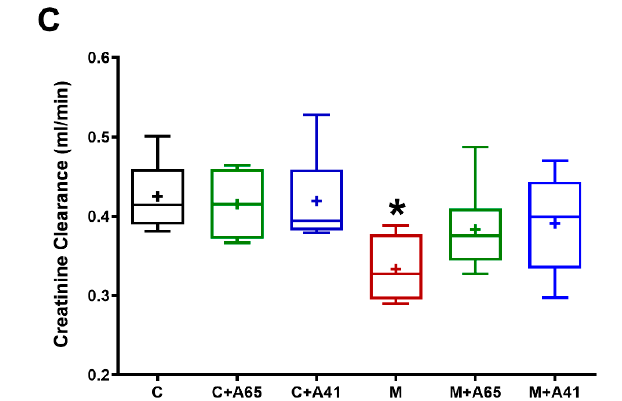
Figure 1. The CB1 receptor antagonists AM6545 and AM4113 improve renal functional parameters in high-fructose high-salt fed metabolic syndrome rats. ( A ) shows the albumin excretion rate (AER), ( B ) shows the proteinuria and ( C ) shows the creatinine clearance measured in control (C) and metabolic syndrome (M) rats as well as after 4 weeks of intraperitoneal injection of AM6545 in control (C + A65) and metabolic rats (M + A65) or AM4113 in control (C + A41) or metabolic rats (M + A41) at a dose of 10 mg/kg/day. Results are shown as box plots and the mean is shown as (+) ( n = 8). * p < 0.05 relative to the control group and # p < 0.05 relative to the metabolic syndrome group by one-way ANOVA followed by Tukey’s post hoc test.